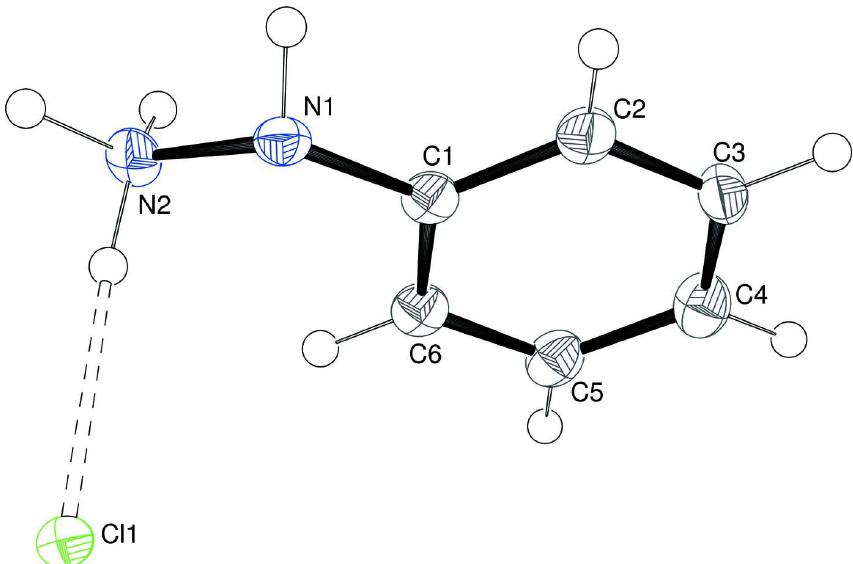
View of the molecular structure of (I) showing 50% displacement ellipsoids. The H atoms are drawn as spheres of arbitrary radius and the hydrogen bond is shown as a double-dashed